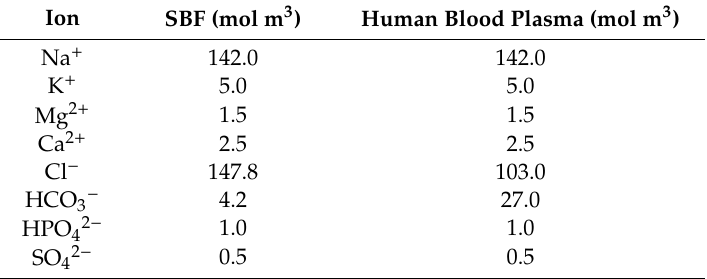
Table 1. The simulated body fluid (SBF)